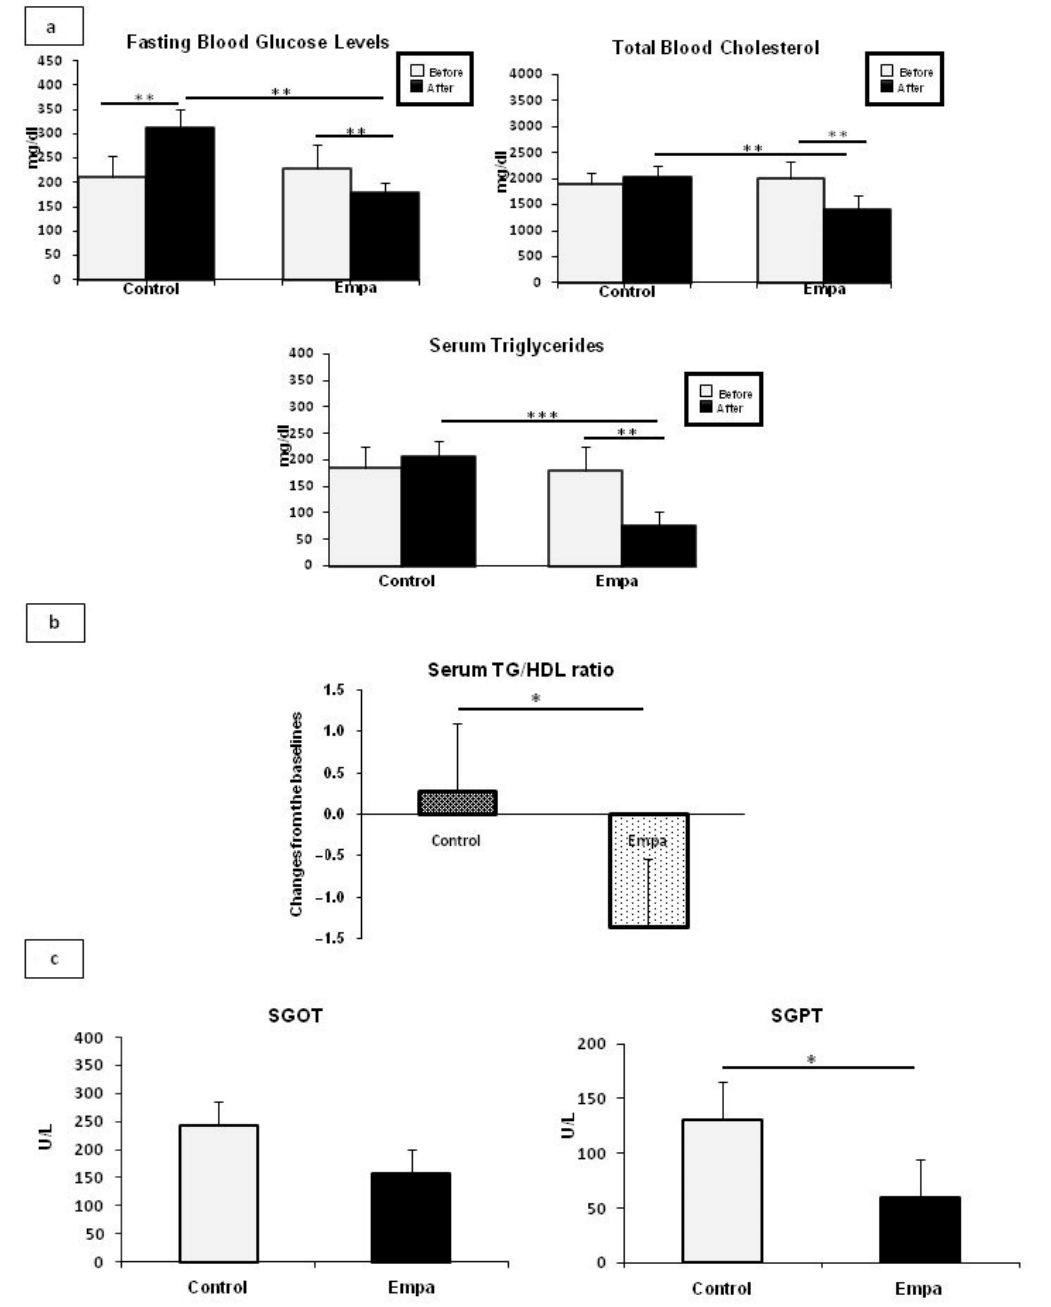
Figure 1. Serum fasting glucose, lipid, SGOT and SGPT concentrations in the Empa and control groups after five weeks of empagliflozin/vehicle oral administration. ( a ). A significant reduction in fasting blood glucose, total cholesterol, triglyceride levels was observed in the Empa group at the end of the treatment period compared to baseline. Fasting glucose was the only significantly increased parameter in the control group at the end of intervention as compared to baseline values. ( b ). Significant changes were detected from baseline in triglyceride/HDL ratio between two groups. ( c ). Serum SGOT and SGPT levels were reduced in Empa group as compared to Control group ( p = 0.07 and p = 0.048, respectively) ( n = 8 per group). Data are shown as the mean ± SD (***: p < 0.001; **: p < 0.01, *: p < 0.05).